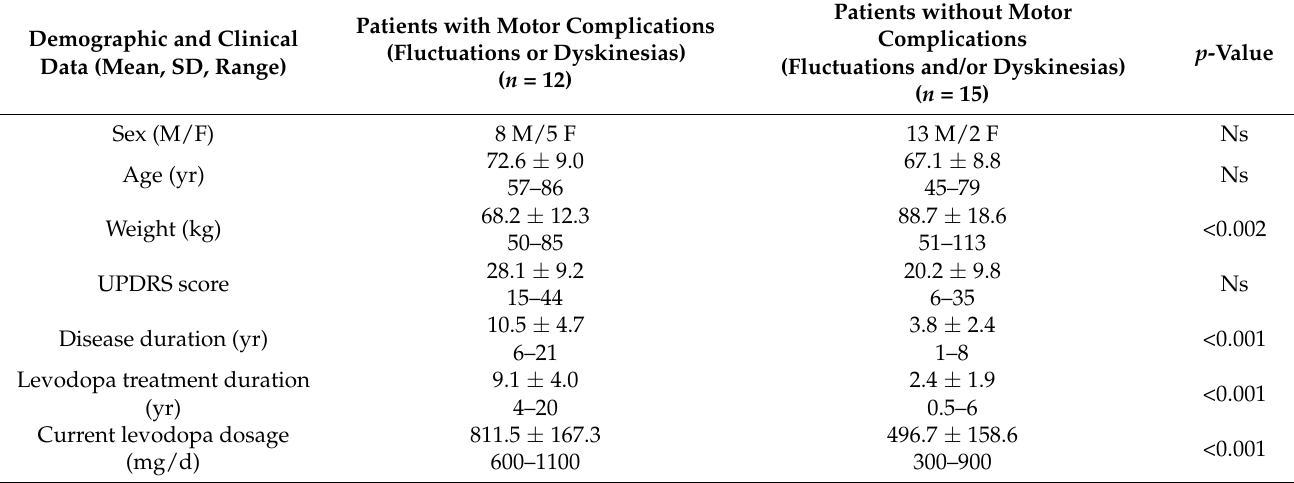
Table 2. Demographic data of patients with motor complications (fluctuations and/or dyskinesias) and without motor